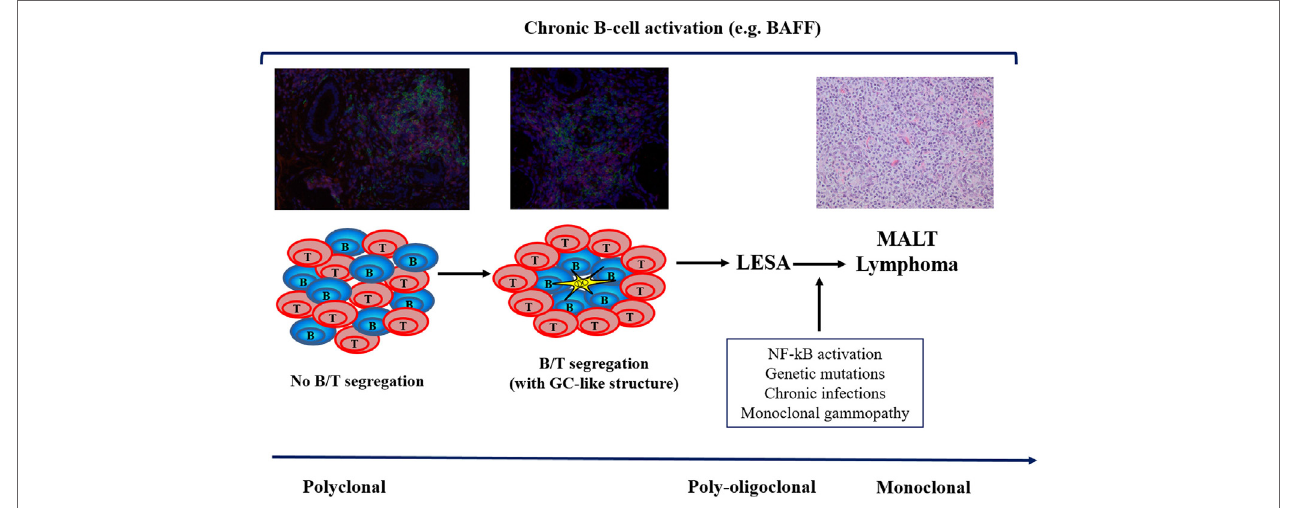
FiGURe 1 | The multistep process of lymphomagenesis in primary Sjögren’s syndrome. BAFF, B-cell activating factor; GC, germinal center; LESA, lymphoepithelial sialadenitis; NF, nuclear factor; MALT, mucosa-associated lymphoid